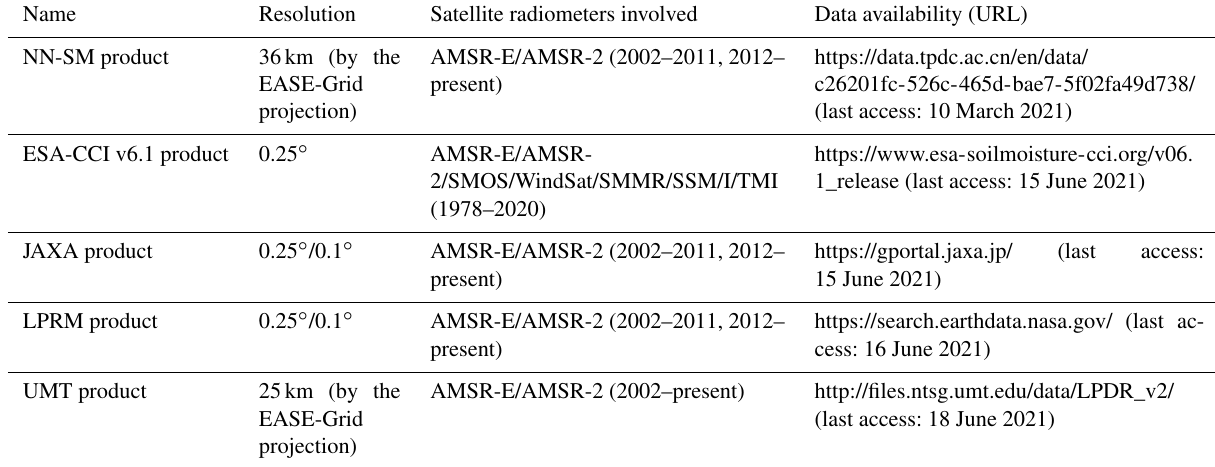
Table 1. Information of all-weather microwave remote sensing coarse-resolution SSM data products that can be potentially downscaled to obtain fine-resolution